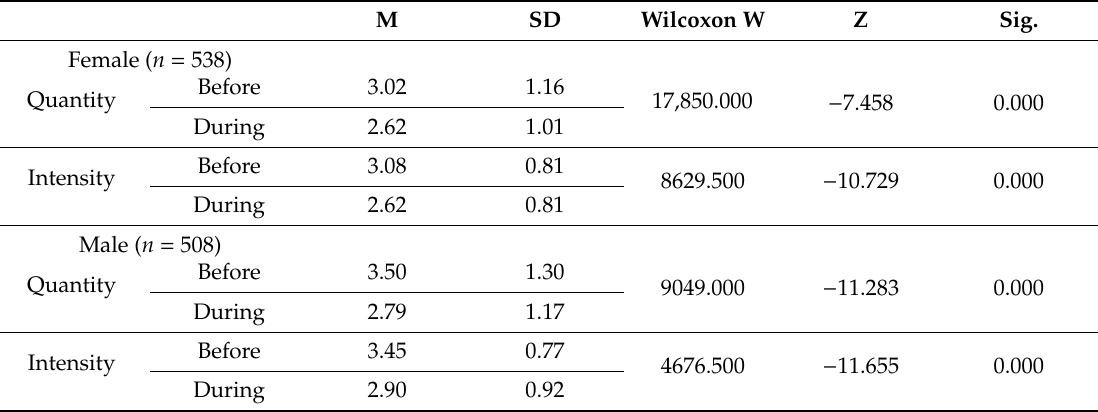
Table 3. Quantity and Intensity of physical activity (PA) before and during the